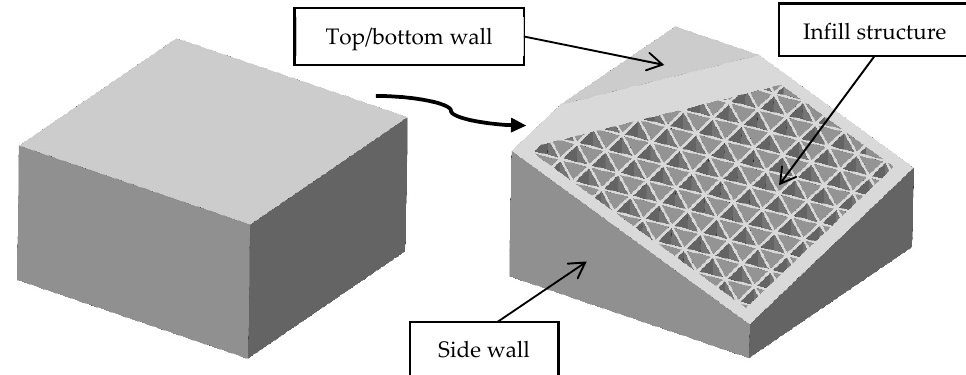
Side wall Figure 1. The components of an AM part with the BMD technique. Figure 1. The components of an AM part with the BMD